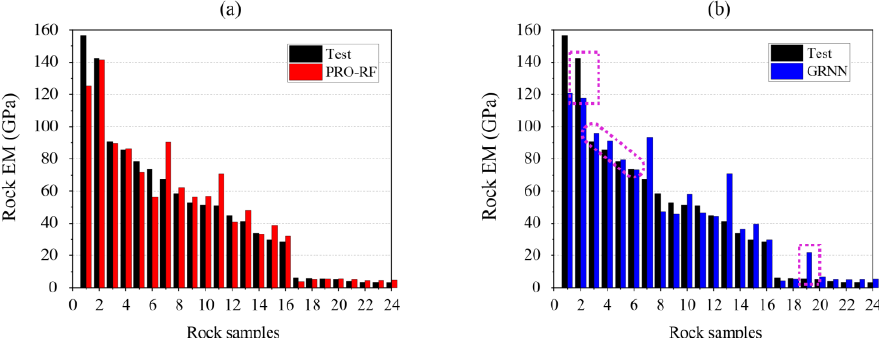
Figure 11. Intuitive comparison diagram of the measured EM and predicted EM by the proposed models: ( a ) PRO-RF model; ( b ) GRNN model. Table 6. Error analysis comparison between the PRO-RF model and the GRNN model.